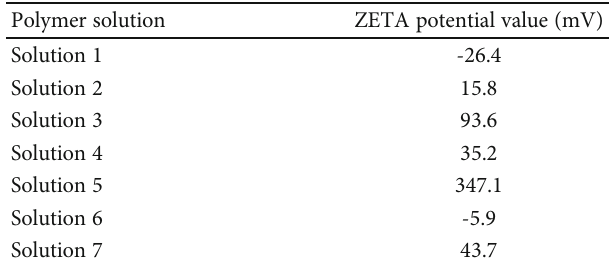
Table 7: Polymer solution ZETA potential tested results. Polymer